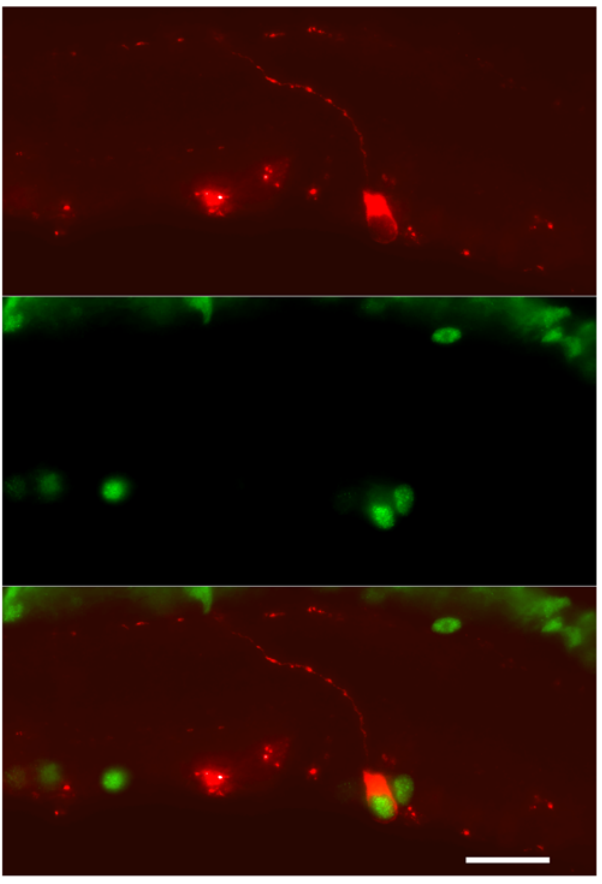
Figure 1. Light-induced c-Fos expression in an ipRGC lacking melanopsin. (upper panel) An M1 ipRGC in the retina of a tau-lacZ + / + mouse identified by b -galactosidase immunostaining. Note the dendrite emanating from this ipRGC extends to the outer aspect of the IPL, bifurcates and stratifies along the border of the INL, contributing to the definition of this ganglion cell as an M1 ipRGC. (middle panel) Same section as in upper panel illustrating light-induced Fos expression in the nuclei of neurons in the ganglion cell layer and INL. (bottom panel) Merged image illustrating light-induced Fos expression in an M1 ipRGC lacking melanopsin.